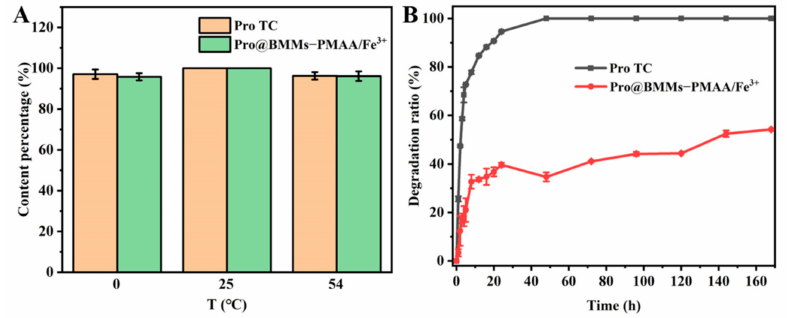
Figure 6. The storage stability ( A ) and the photostability ( B ) of Pro@BMMs − PMAA/Fe 3+